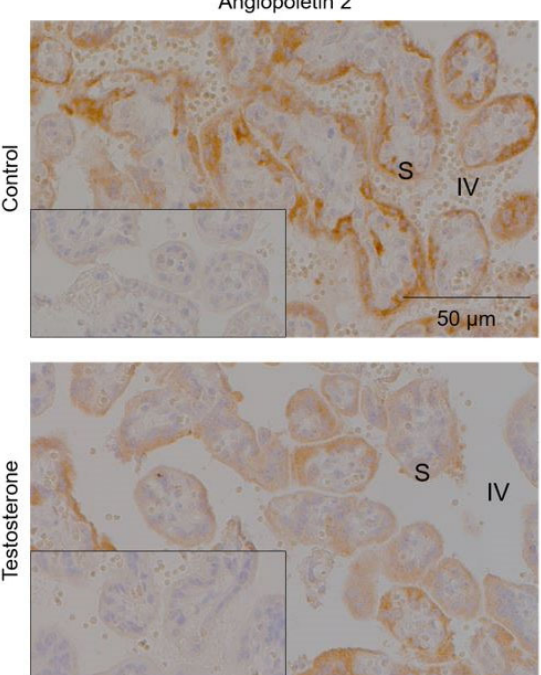
Figure 4. Testosterone attenuated staining of angiopoietin 2 in the syncytiotrophoblast of the placenta. Representative images showing that testosterone significantly decreased angiopoietin 2 staining (brown) in chronic villi ( F 1,7 = 5.96, p = 0.045). The average ± standard deviation area of staining corrected for total area analyzed was 0.08 ± 0.01 µ m for control animals and 0.06 ± 0.01 µ m for T-treated animals. Sections are counterstained with hematoxylin (blue). Insets show corresponding negative control sections that were stained using IgG. S: syncytiotrophoblast; IV: intervillous space. In examining the degree of correlation between the MB ‐ PS signal and inflammatory markers, the linear regression analysis revealed that the MB ‐ PS signal and ANGPT2 were significantly and negatively related (Figure 5; R 2 = 0.31, p = 0.045).